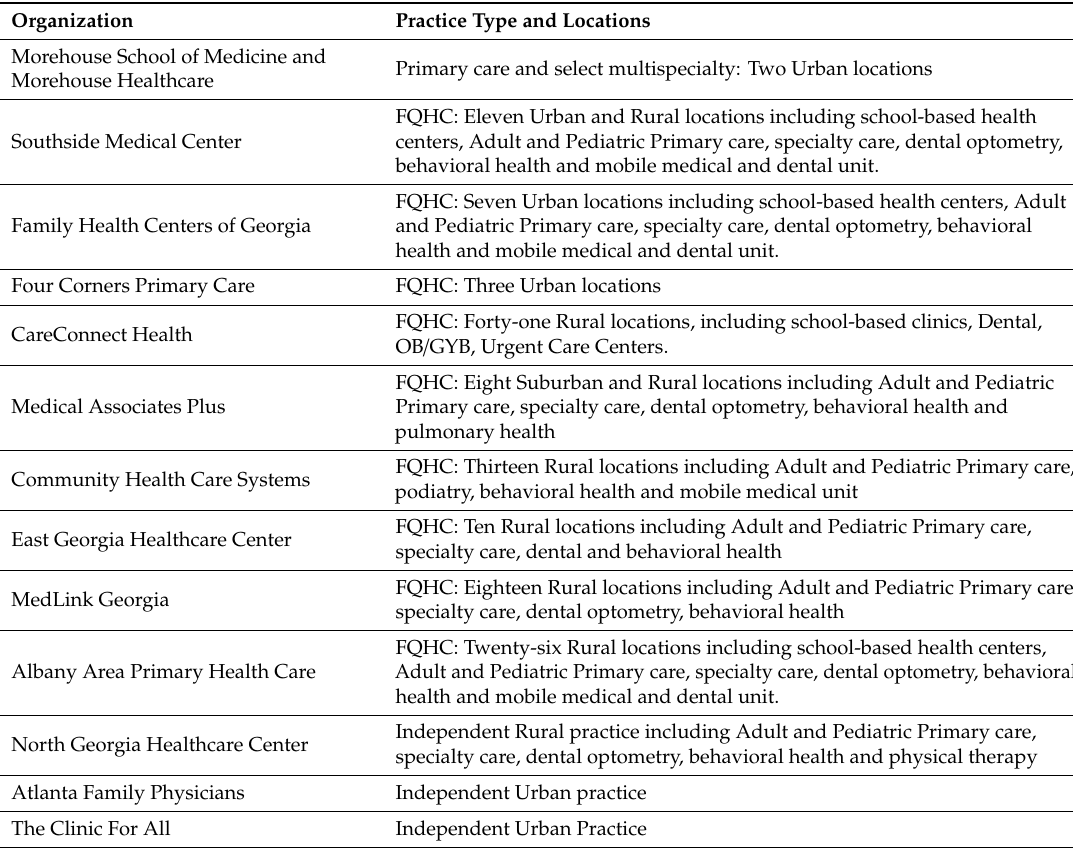
Table 1. M-ACO Participant Organizations and Health Center Locations Across Urban and Rural